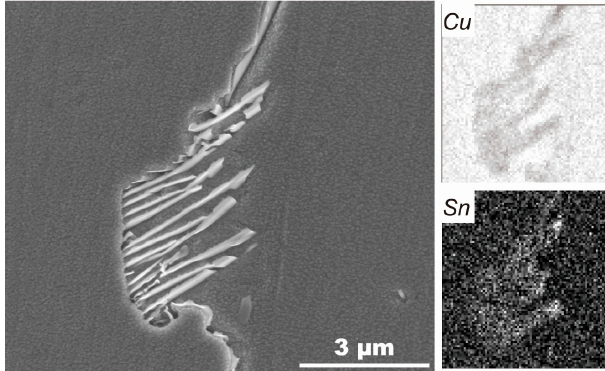
Figure 6. Energy-dispersive X-ray (EDX) map of Cu and Sn taken from the second phase in 0.02% Ti alloy aged at 400 °C for 4 h.